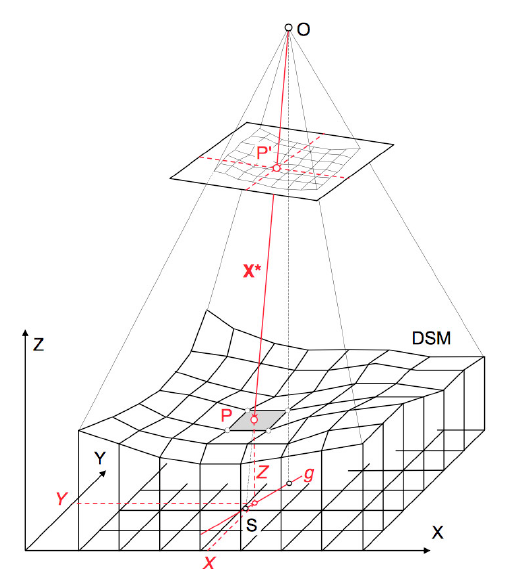
Figure 3: Principle of Monoplotting method